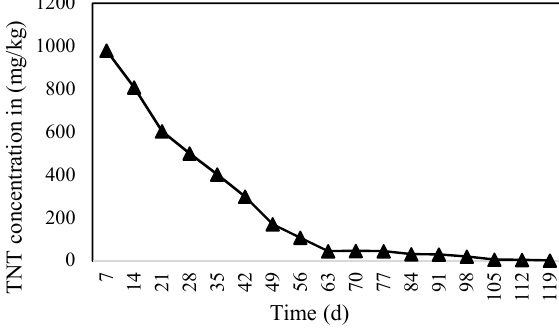
Fig. 2. Disappearance of TNT in presence of rhamnolipid in induced aeration (TNT= 1000 mg/kg)